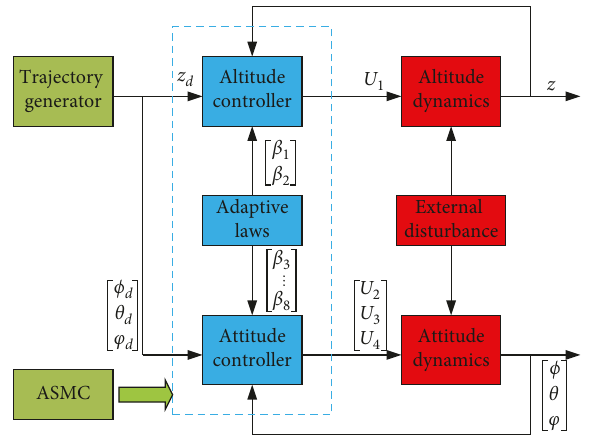
Figure 2: The proposed control